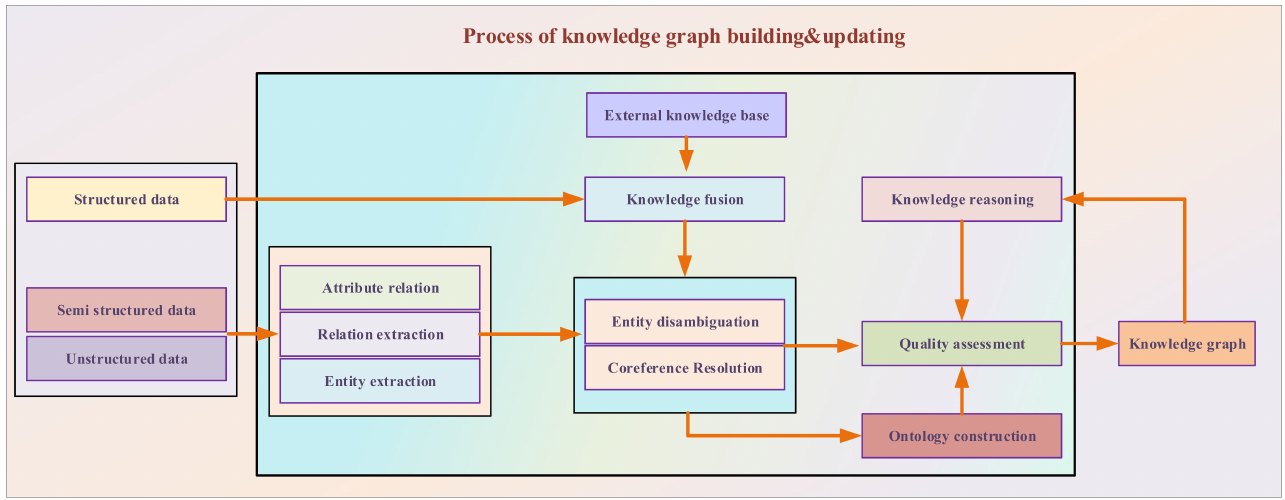
Figure 4. Schematic of the knowledge graph